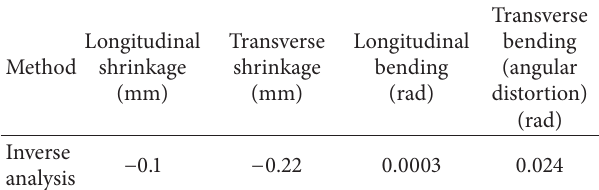
Table 1: Inherent deformations in the fillet